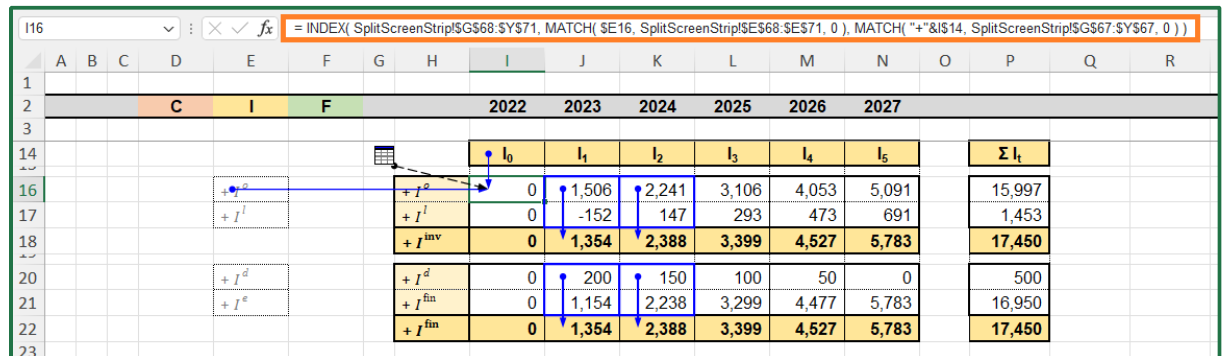
Figure 43. Cell I16 contains the formula for picking the operating income 𝐼 (cid:3042) as of period 𝑡 = 0;